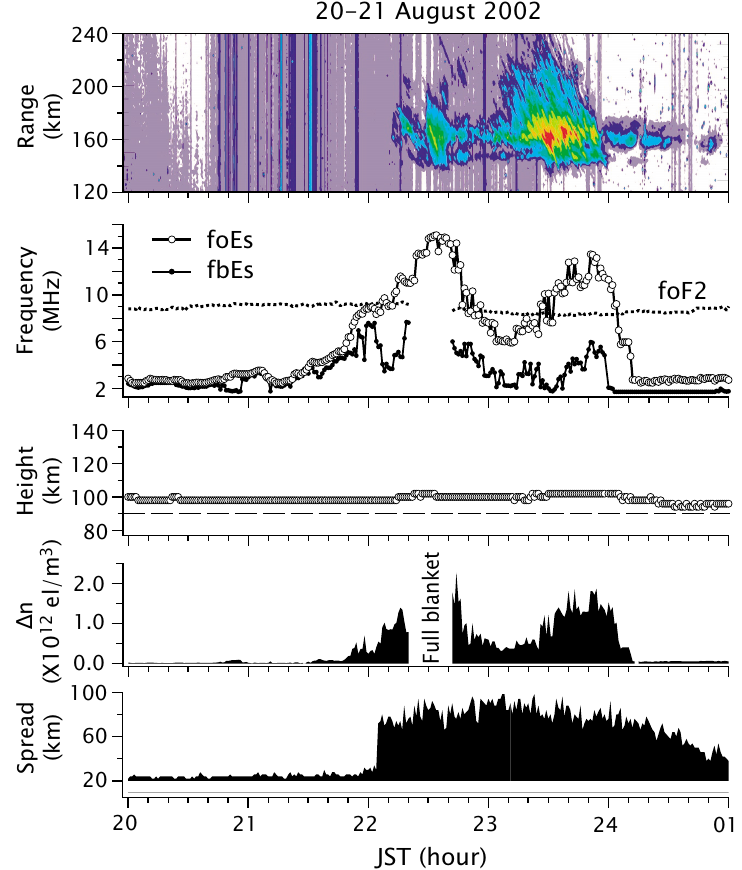
Fig. 4. Same as Fig. 3, but for the night of 20 to 21 August